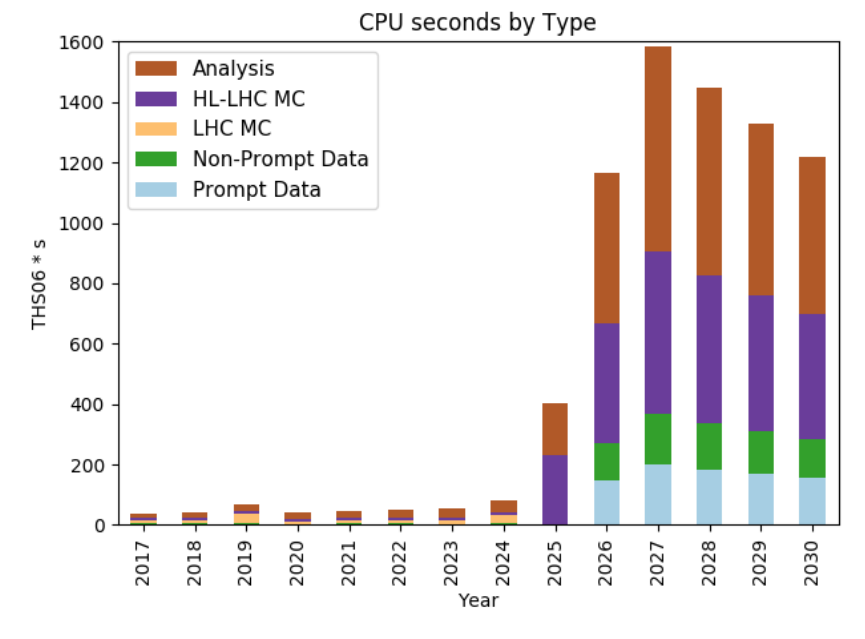
Figure 1. Trigger rates and Luminosity for HL-LHC